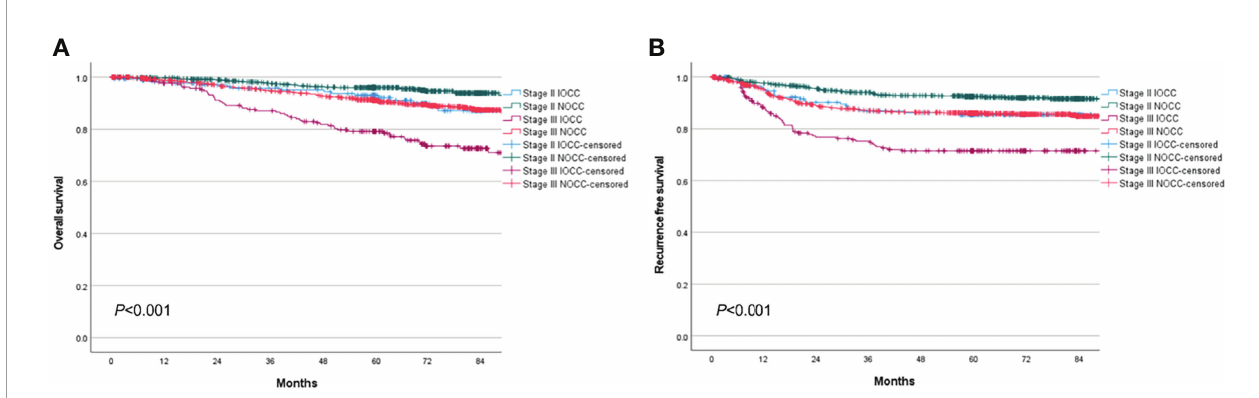
FIGURE 2 | Overall survival and recurrence-free survival between IOCC and NOCC by stage. (A) Overall survival by obstruction status and stage. (B) Recurrence- free survival by obstruction status and stage.